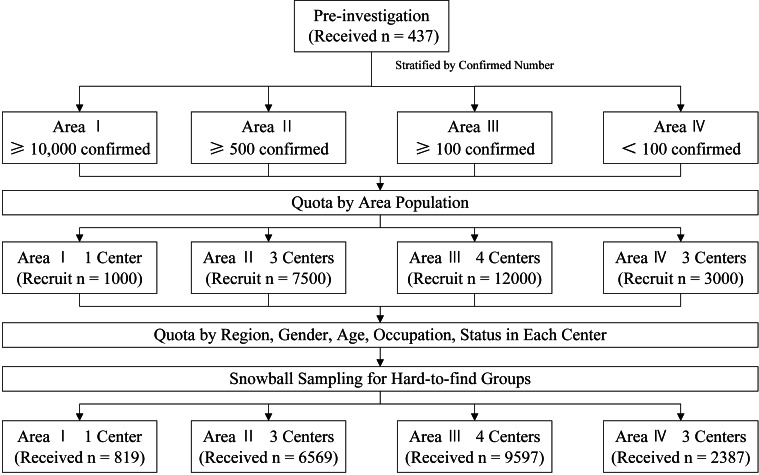
Flow diagram showing the sampling process.